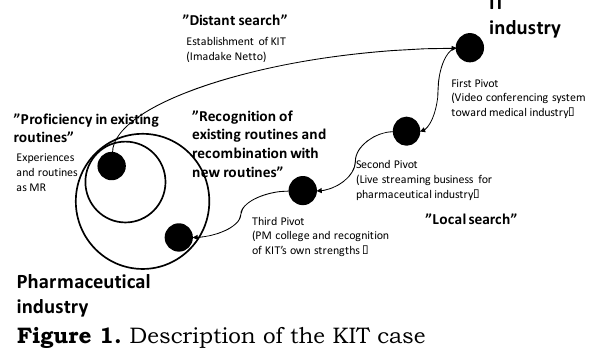
Figure 1. Description of the KIT case Source: This figure was created by the